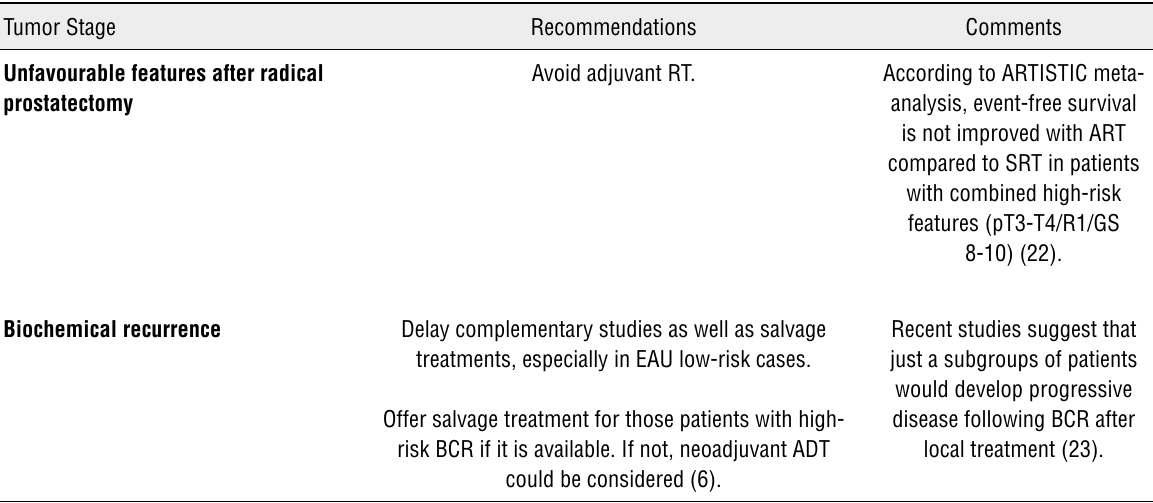
Table 2- Management of unfavourable features after radical prostatectomy or biochemical recurrence after local treatment of PCa during the COVID-19 era. Tumor Stage